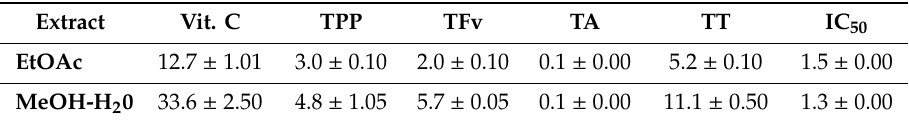
Table 3. Total polyphenols (TPP), total flavonoids (TFv), total anthocyanins (TA), and total tannins (TT) content in Z. lotus solvent